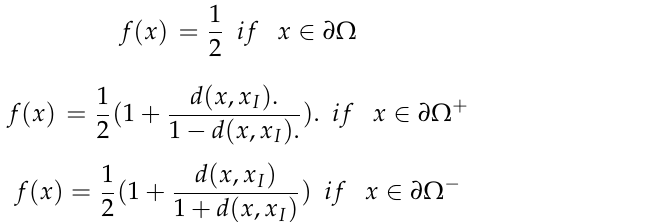
Figure 3. Illustration of relations between the boundary and a superpixel block. ( a ) superpixel is outside of the boundary; ( b ) superpixel is inside of the boundary; ( c ) superpixel intersects with the boundary.